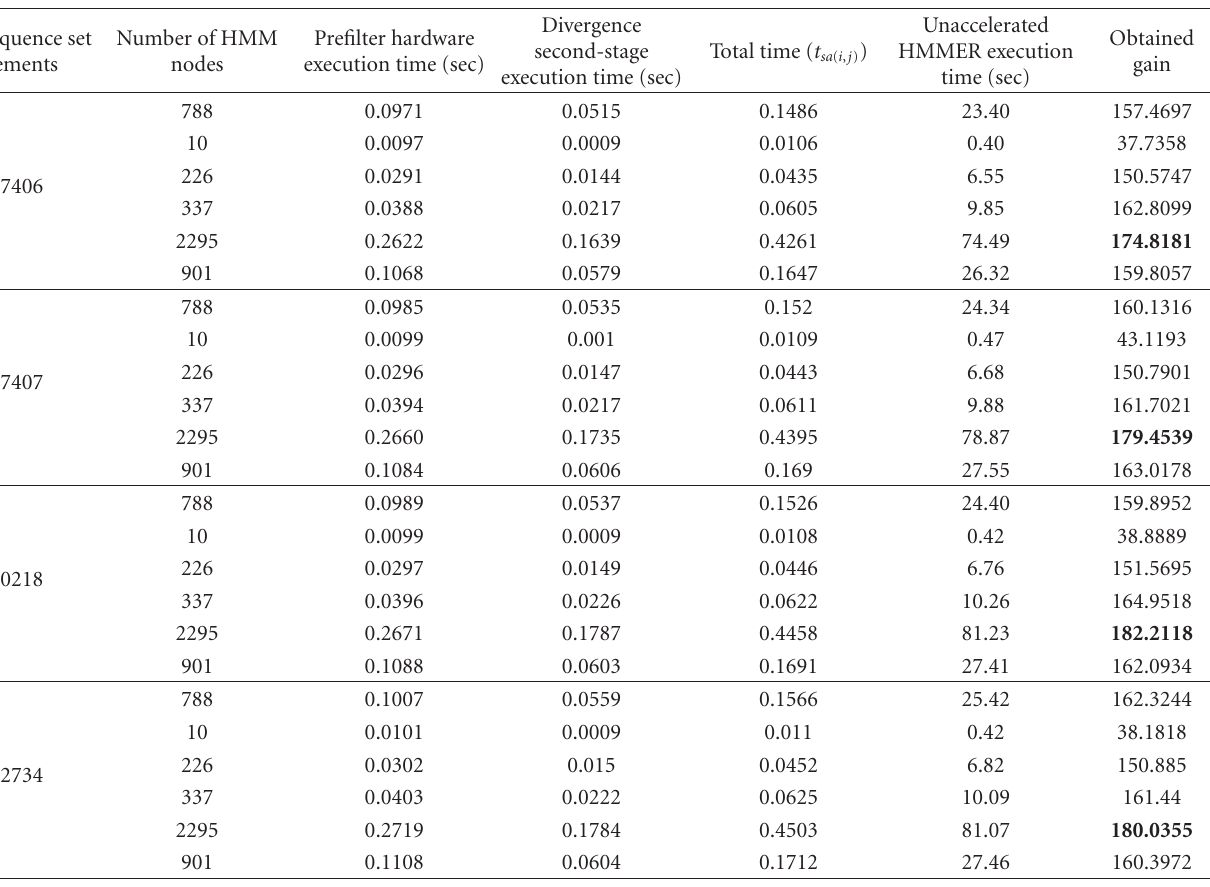
Table 7: Total system performance and obtained performance gains.